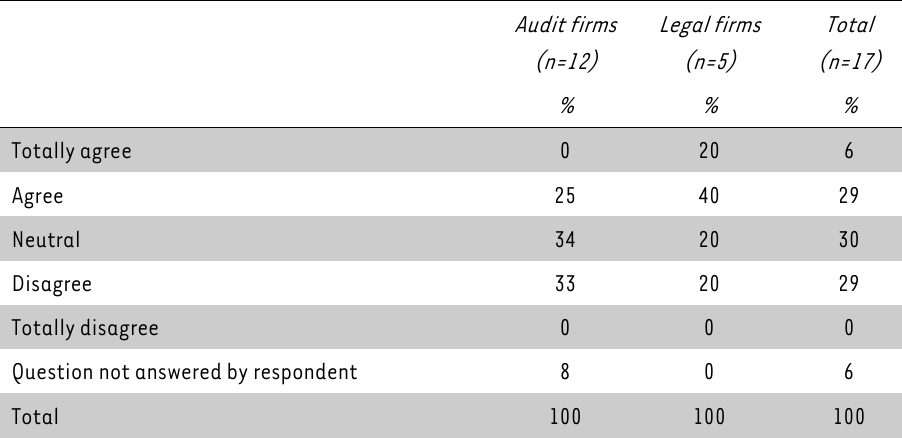
TABLE 11 Results of Question 8